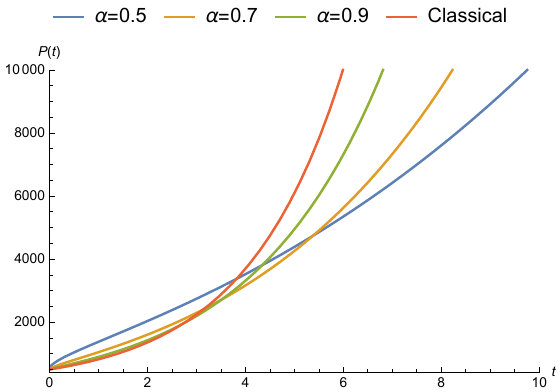
Figure 5. Analysis of the Malthusian growth model under different orders while β = 0.9.